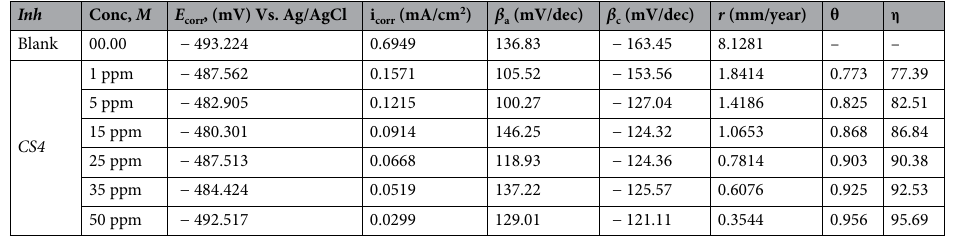
Table 3. Tafel parameters for CS -metal before and after the addition of various concentrations of CS4 compound at room temperature.